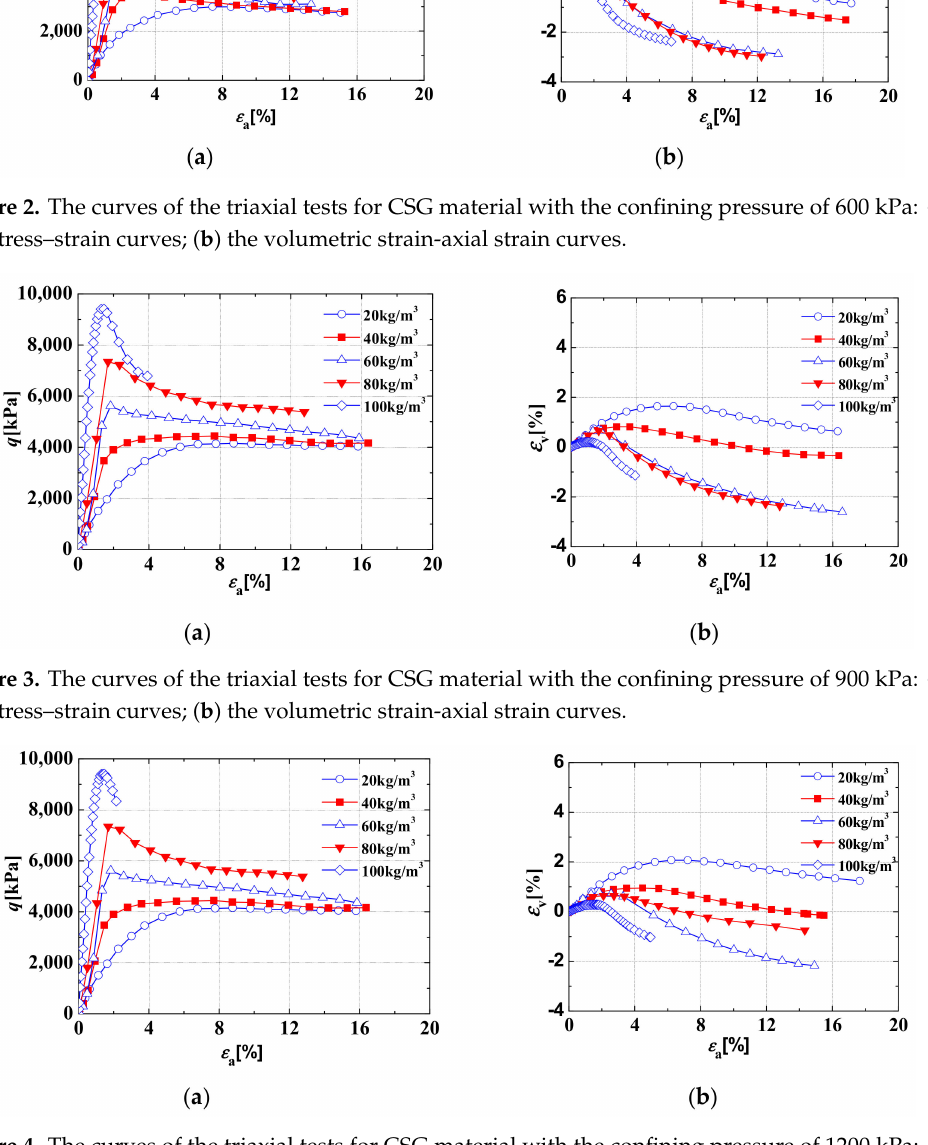
Figure 4. The curves of the triaxial tests for CSG material with the confining pressure of 1200 kPa: ( a ) the stress–strain curves; ( b ) the volumetric strain-axial strain